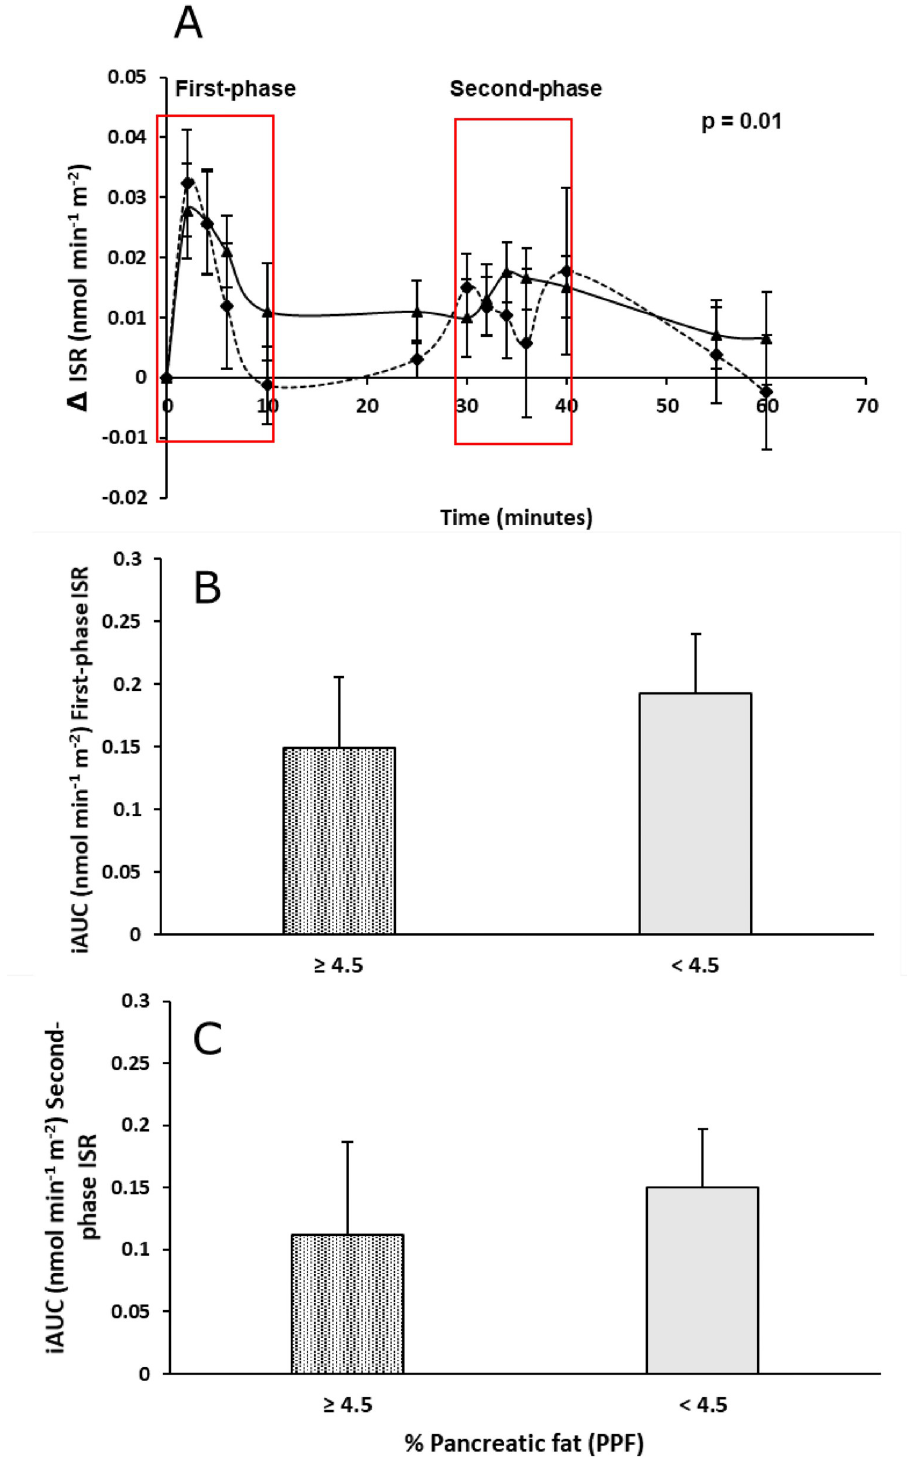
Fig 4. Rate of insulin secretion over the 60-min test period in women according to MR-determined percentage pancreatic fat (PPF) cut off ( � 4.5% pancreatic fat–solid diamond, dash lines; < 4.5% pancreatic fat–solid triangle, solid line, A) and incremental area under the curves (iAUC) for first- and second-phase insulin response determined for each pancreatic fat sub-group (B, C). The change from baseline ( Δ ) peak first-phase ISR (0.03 ± 0.03 nmol min -1 m -2 ) was significantly greater (p = 0.01) than the Δ peak second-phase ISR (0.01 ± 0.03 nmol min -1 m -2 ).